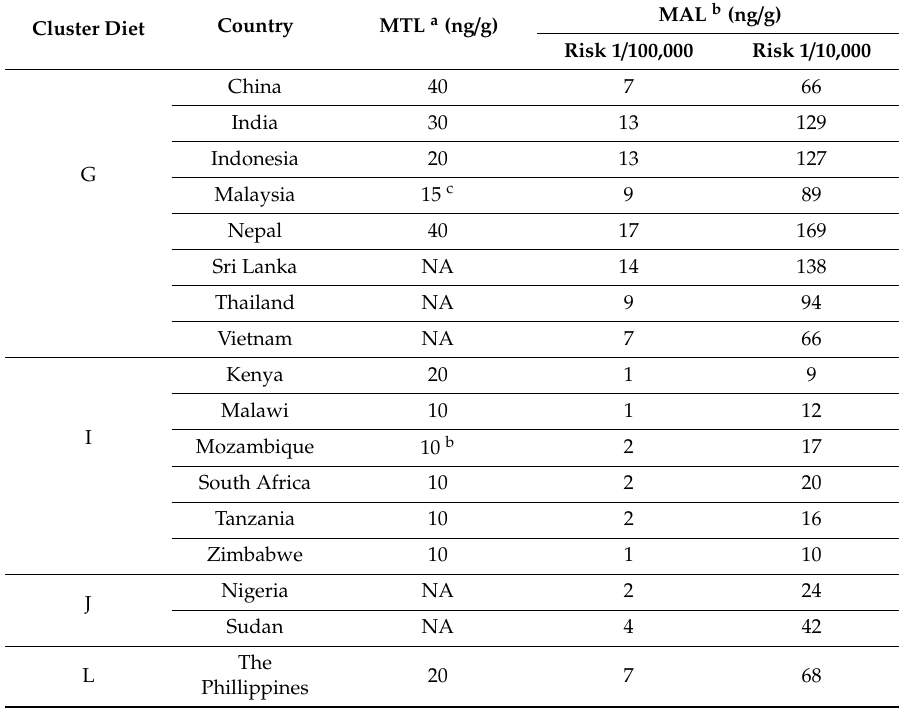
a Current o ffi cial standards for MTL in peanut and maize; b maximum allowable levels calculated as the maximum levels of AFB1 contamination that would cause a lifetime risk increase of one case HCC in 10,000 or 100,000 individuals in a population; c Standard for peanut only. Abbreviations: NA: Not available; HB: Hepatitis virus B; JECFA: The joint Food and Agriculture Organization (FAO) / World Health Organization (WHO) Expert Committee on Food Additives and